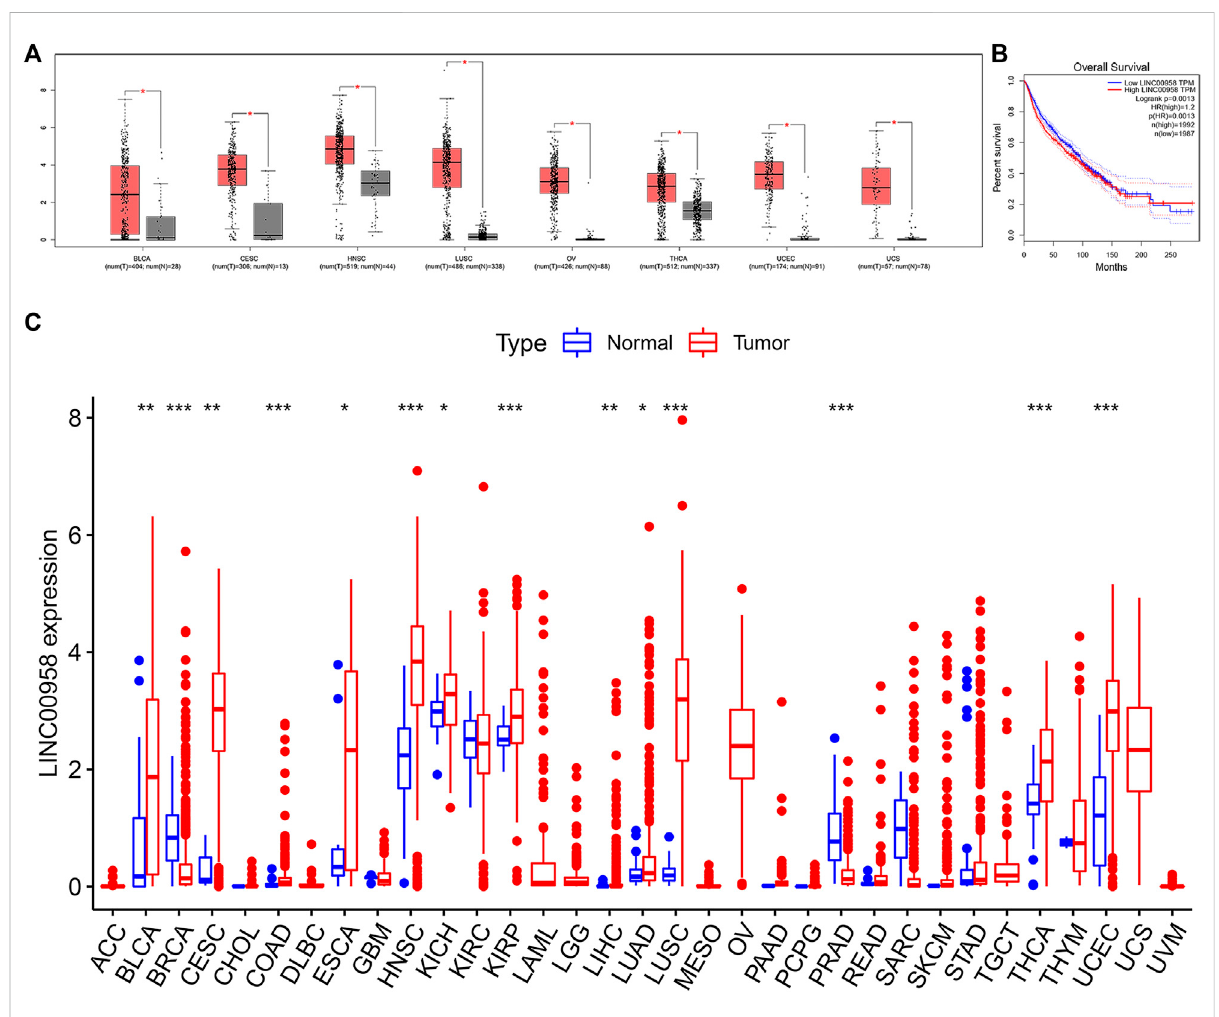
FIGURE 5 Validation of the role of LINC00958 in human cancers in public databases. (A) The expression of LINC00958 in human cancers (red box) and normal tissues (gray box) based on the TCGA and GTEx databases (|Log2FC| > 1 and p < 0.01); (B) Overall survival (OS) plots based on LINC00958expressioninninetypesofcancer( n =3,979); (C) LINC00958expressionlevelsinpan-cancerfromTCGAdata.* p < 0.05,** p < 0.01,and *** p <